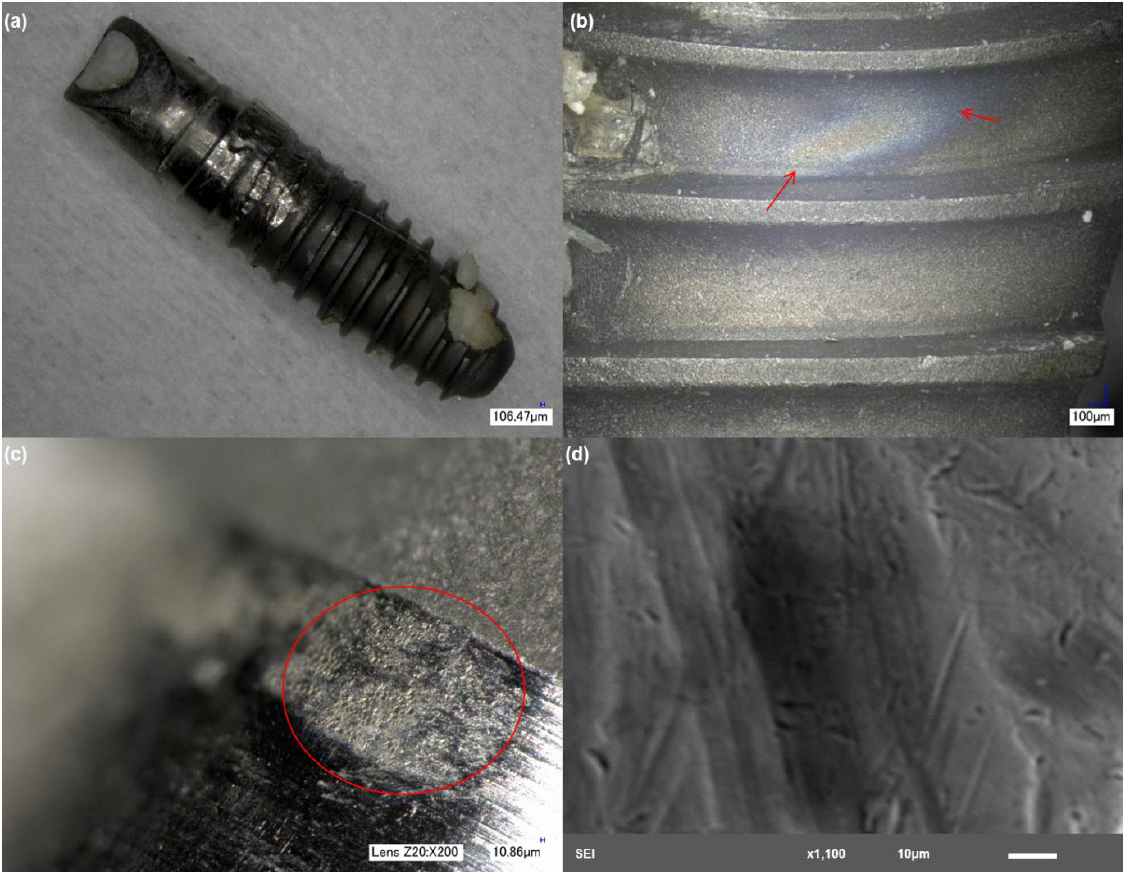
Figure 4. Structure of implant 3. ( a ) Low magnification showing the gross features of the implant and bone attachment to the bottom part of the surface; ( b ) discoloration is also evident in this example; ( c ) severe pitting attack on the top interface of the implant in the abutment region; and ( d ) higher magnification of an area of the abutment with